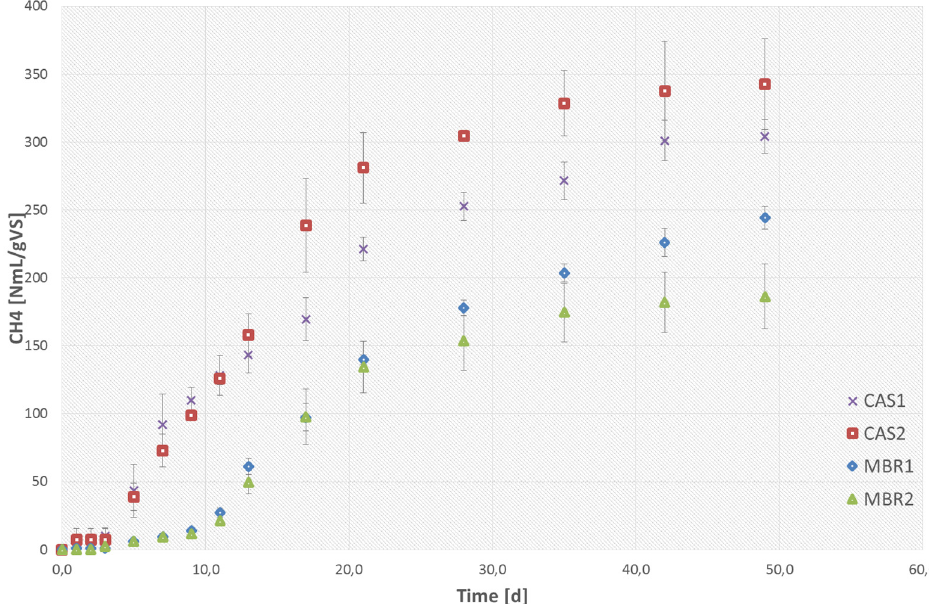
Figure 8. Cumulative specific methane productions of membrane bioreactor (MBR) sludge and Conventional Activated Sludge (CAS).